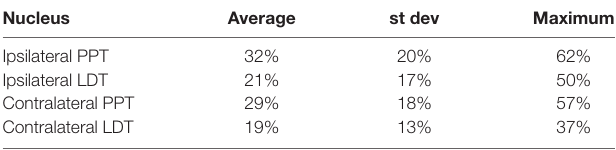
TABLE 2 | Percentage of retrograde cells in each nucleus that were ChAT+. TABLE 3 | Distribution of tracer-labeled, ChAT+ cells in the PMT nuclei.